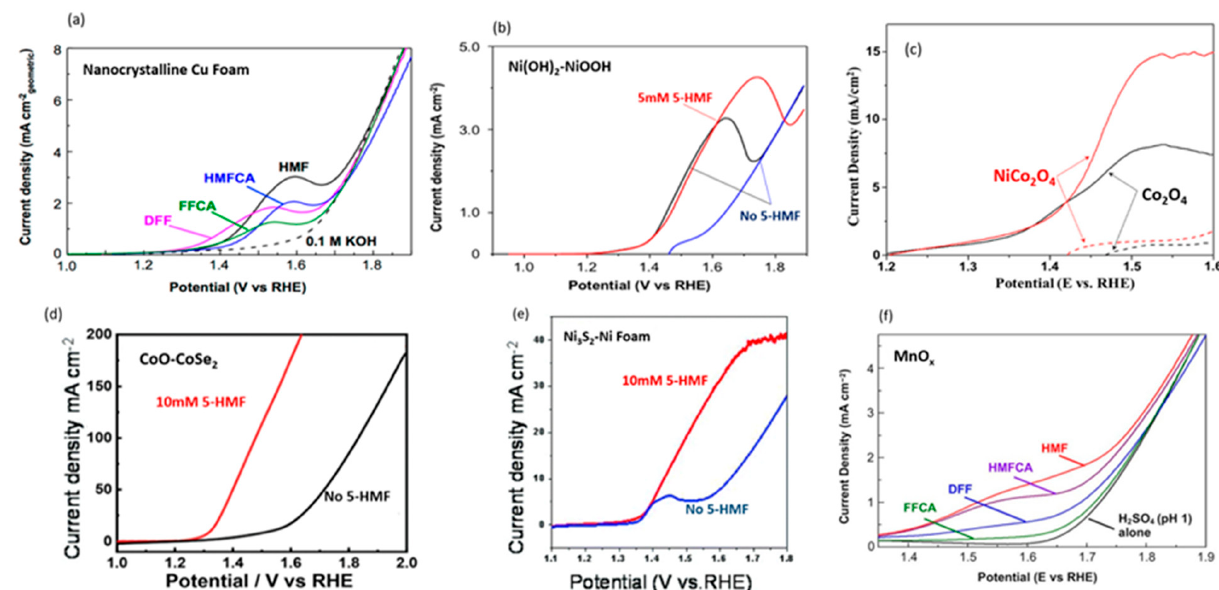
Figure 13. Comparison of LSV graphs with different catalysts. ( a ) LSV scans of 5 mM of 5-HMF and intermediates (solid lines) and without 5-HMF (dashed line) at a pH of 13 using nanocrystalline Cu foam. Reprinted with permission from Ref [68]. Copyright 2018, ACS Catalysis. ( b ) LSV of Ni(OH) 2 catalysts without (blue and black lines) and with 5 mM 5-HMF (red line) at a pH of 13. Reprinted with permission from Ref [69]. Copyright 2019, ACS Catalysis. ( c ) LSV of NiCo 2 O 4 and Co 3 O 4 catalysts without (dashed lines) and with (solid lines) 5 mM 5-HMF, at a pH of 13. Reprinted with permission from Ref [70]. Copyright 2019, Applied Catalysis B: Environmental. ( d ) LSV of CoO-CoSe 2 electrocatalysts without (black line) and with (red line) 10 mM 5-HMF at a pH of 13. Reprinted with permission from Ref [72]. Copyright 2020, Green Chemistry. ( e ) LSV of Ni 3 S 2 -Nickel foam without (black line) and with (red line) 10 mM 5-HMF at a pH of 13. Reprinted with permission from Ref [74]. Copyright 2021, Dalton Transactions. ( f ) LSV of 20 mM 5-HMF and intermediates (colored lines) and without (black line) with MnO x at a pH of 1. Reprinted with permission from Ref [75]. Copyright 2018, ChemSusChem.